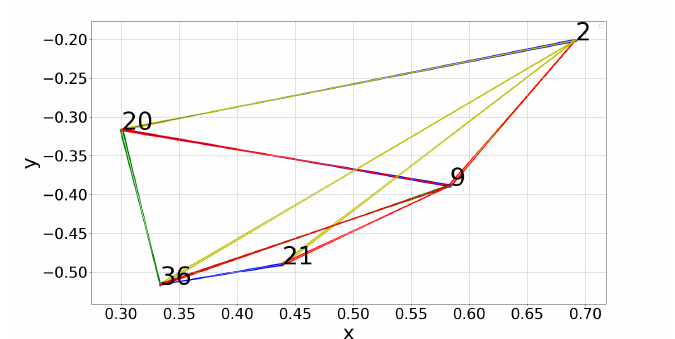
Figure 7. Graph constructed from a set of sampled reachable